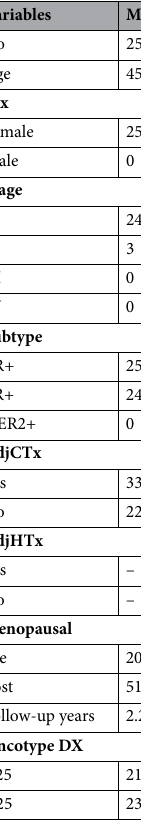
Table 1. Clinical characteristics of the hormone receptor-positive breast cancer patients for the model development cohort, the prognosis validation cohort, and TCGA BRCA cohort. AdjCTx adjuvant chemotherapy, AdjHTx hormone